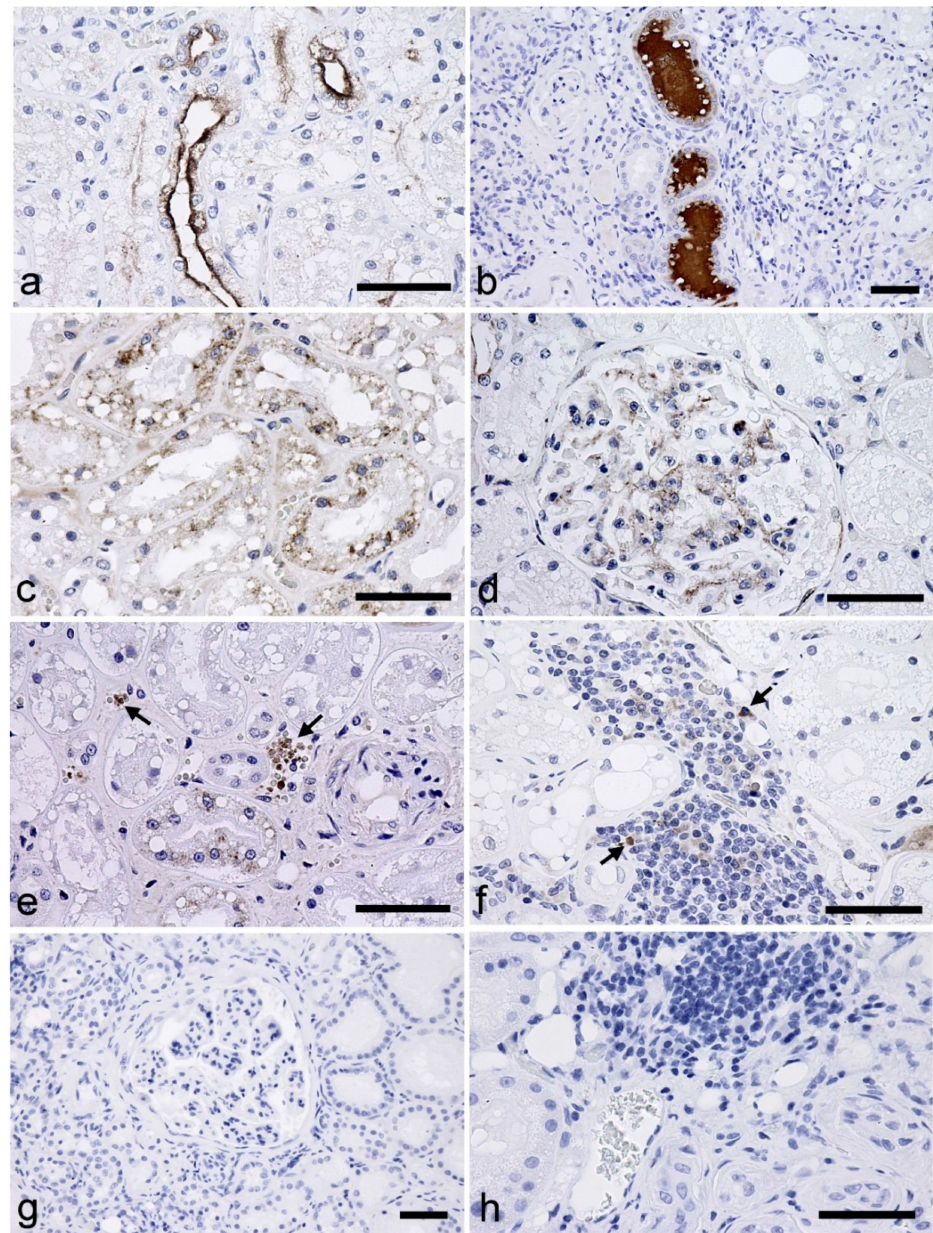
Figure 2. Immunohistochemistry for the detection of the transforming growth factor-beta 1 (TGF- β 1) in the kidneys of cats with chronic kidney disease (CKD). ( a ) Immunolabeling is evident in the apical surfaces of the distal tubules and collecting ducts. ( b ) The luminal spaces of some tubules exhibiting strong immunosignals. These tubules are classified as distal tubules or collecting ducts based on their morphologies. ( c ) Granular immunosignals in the proximal tubular cells. ( d ) Immunolabel- ing in the glomerular mesangial cells. ( e ) Immunosignals in the platelets of the vascular system (arrows). ( f ) Positive cells observed in the focally infiltrated mononuclear cells (arrows). ( g , h ) No immunolabeling was observed in the negative control sections. Scale bar: 50 µ